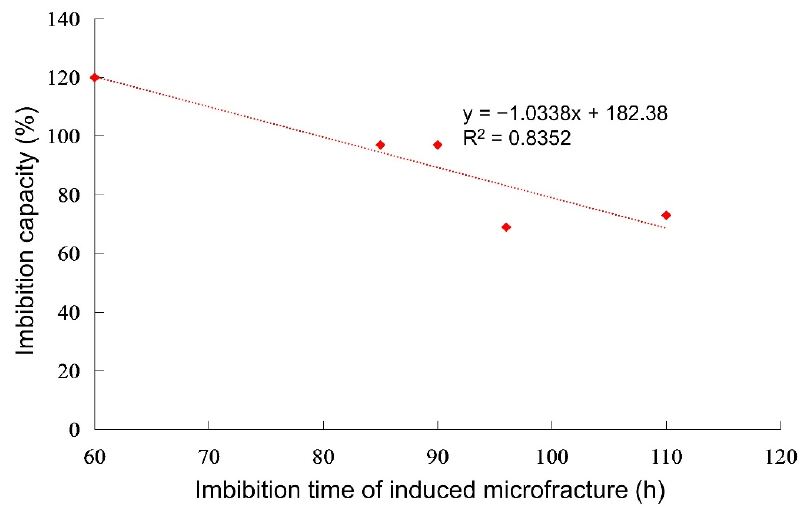
Figure 18. The relationship between induced microfracture initiation time and imbibition capacity.